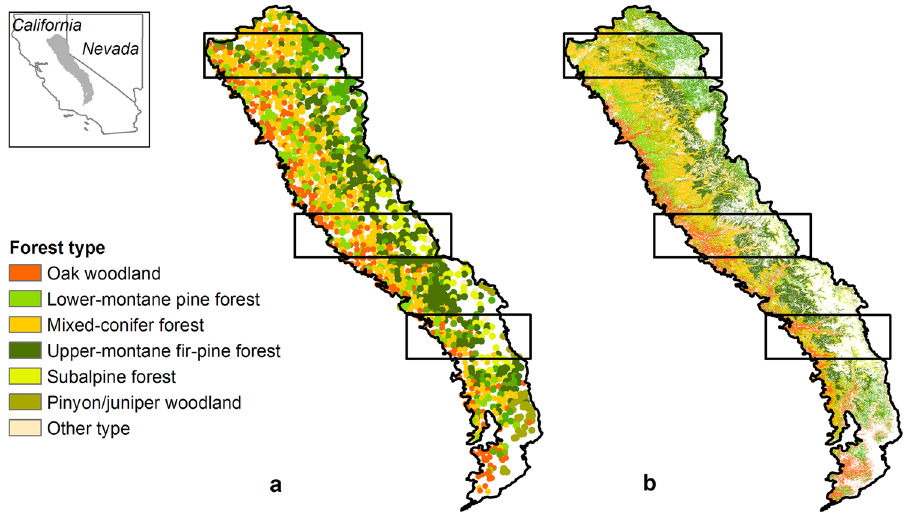
Figure 1. Spatial distribution of simulation transects. The polygons show the three transects simulated in the northern, central and southern Sierra Nevada, USA. ( a ) Distribution of forest types derived from FIA plots. ( b ) Initial distribution of simulated forest types derived from FIA data (see supplementary material). Maps were created using ArcGIS 10.1